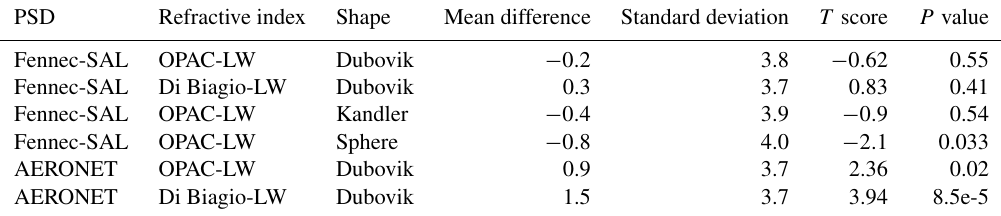
Table 4. The difference in OLR between our computations and the CERES measurements for the selected dust cases. The values in the table are based on the assumption of 0.7Wm − 2 bias in our clear-sky OLR